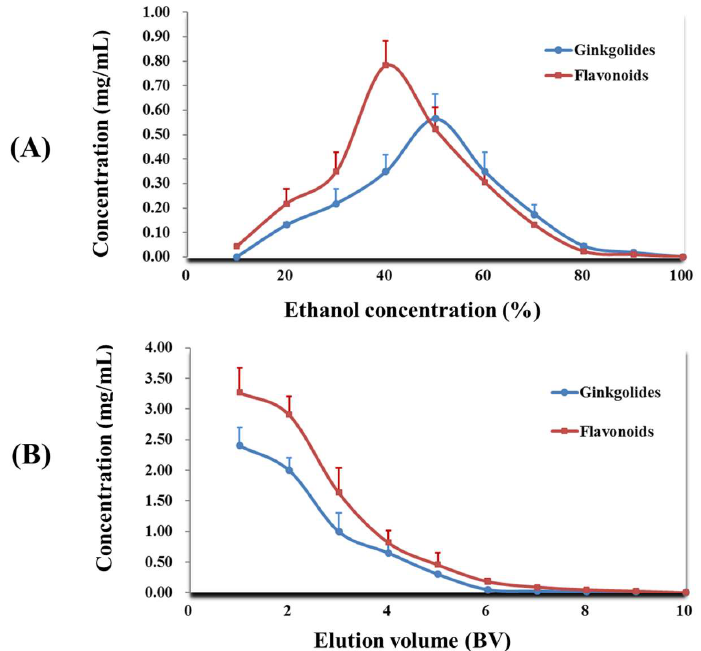
Figure 5. Elution conditions of flavonoids and ginkgolides from DA-201 macroporous resin. ( A ) Effect of ethanol concentration on desorption of total target compounds; and, ( B ) effect of elution volume on desorption of total target compounds. Results were expressed as the mean value ± standard deviation ( n = 3).